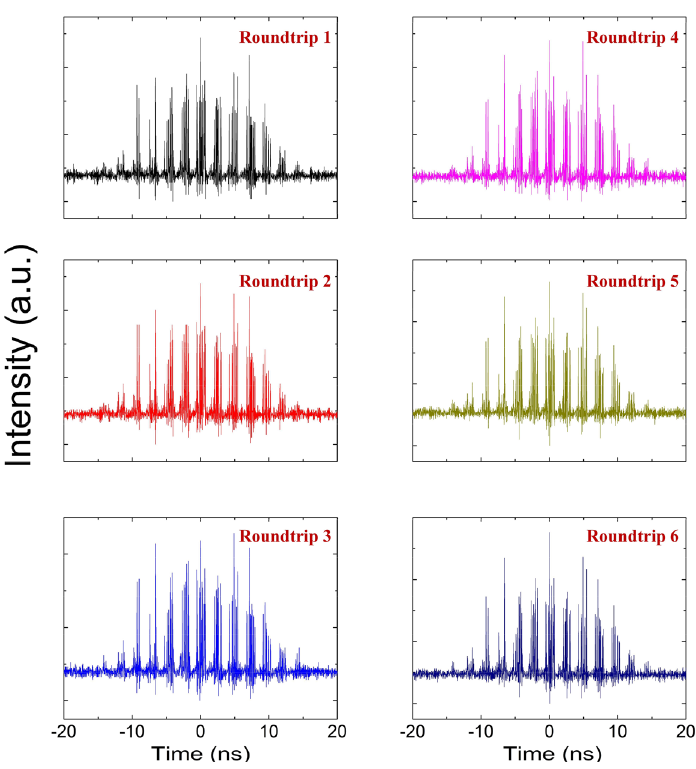
Figure 6: Evolution of multiple-pulse bunch over suc- cessive